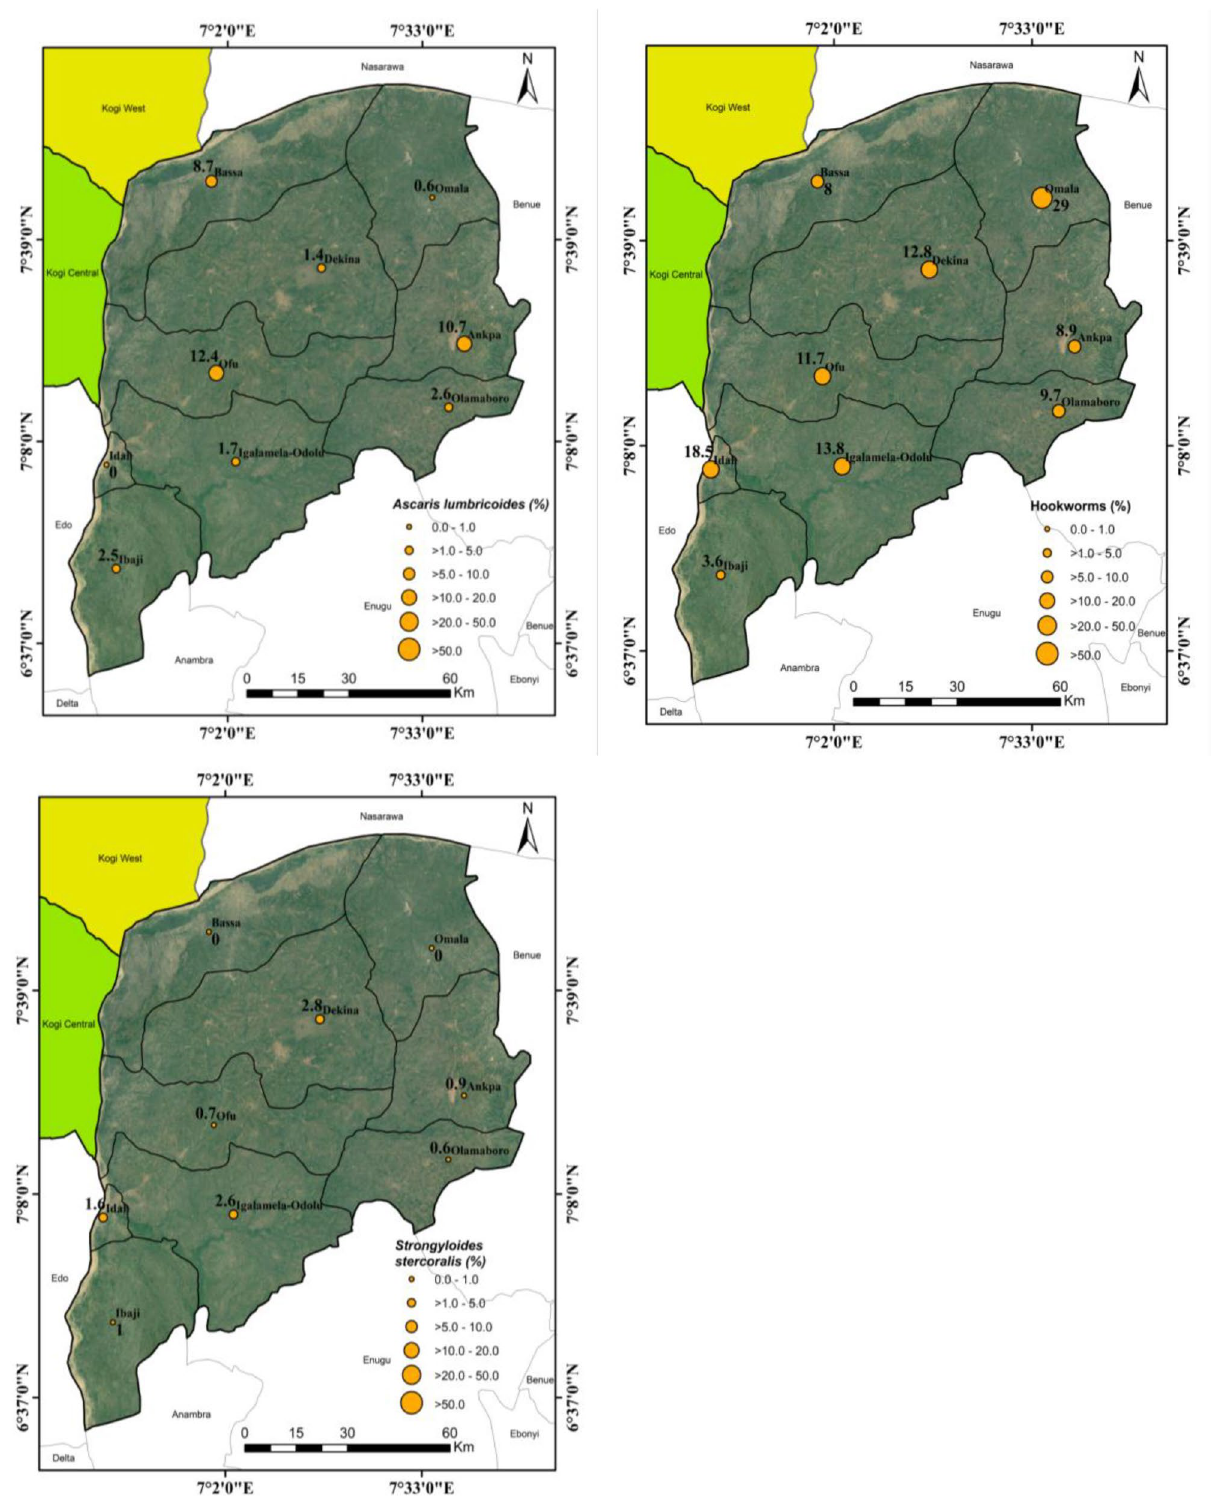
Figure 2. Spatial Distribution of STHs in Local Government Areas of Kogi East, North Central Nigeria. Source of Satellite Imagery: Image Google Earth: Landsat/Copernicus (Data SIO, NOAA, U.S. Navy, NGA, GEBCO. Maps were visualized on ArcMap 10.1. https:// www. google. com/ maps/ place/ Kogi/@7. 31959 59,7. 26328 04,18932 4m/ data= !3m1!1e3!4m5!3m4!1s0x1 04f41 e9d61 f12dd: 0xbdc 9f94f 2d58a afd!8m2!3d7. 73373 25!4d6. 69058